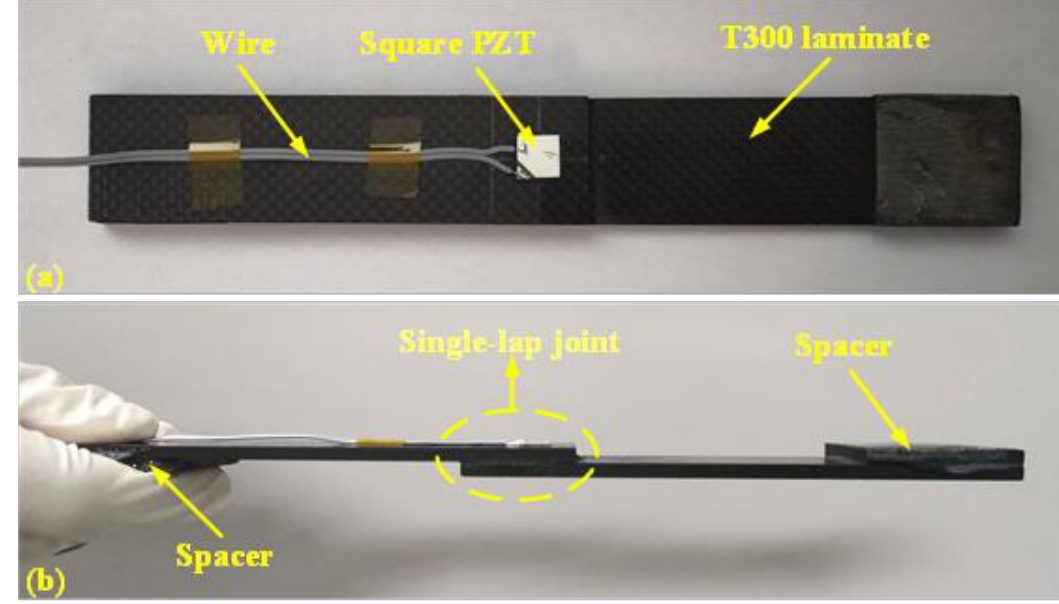
Figure 1. Standard specimen for tensile test: ( a ) top view; ( b ) side view.